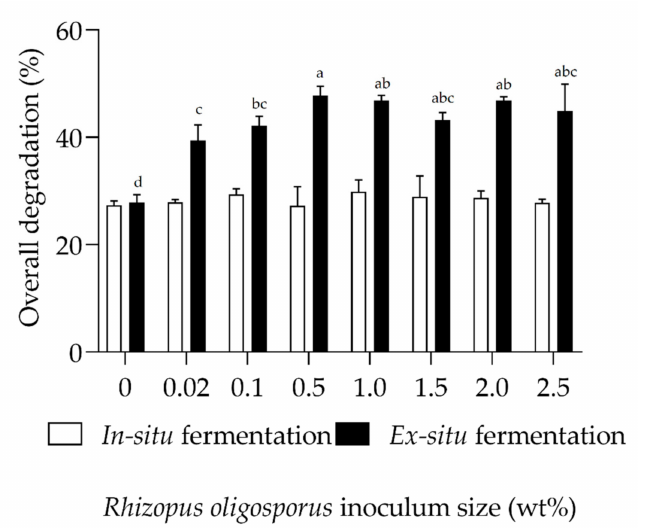
Figure 1. Overall degradation of CEW by BSFL at various inoculum sizes of R. oligosporus performing in situ and ex situ fermentations. Mean values with different superscript characters signify the significant differences ( p <